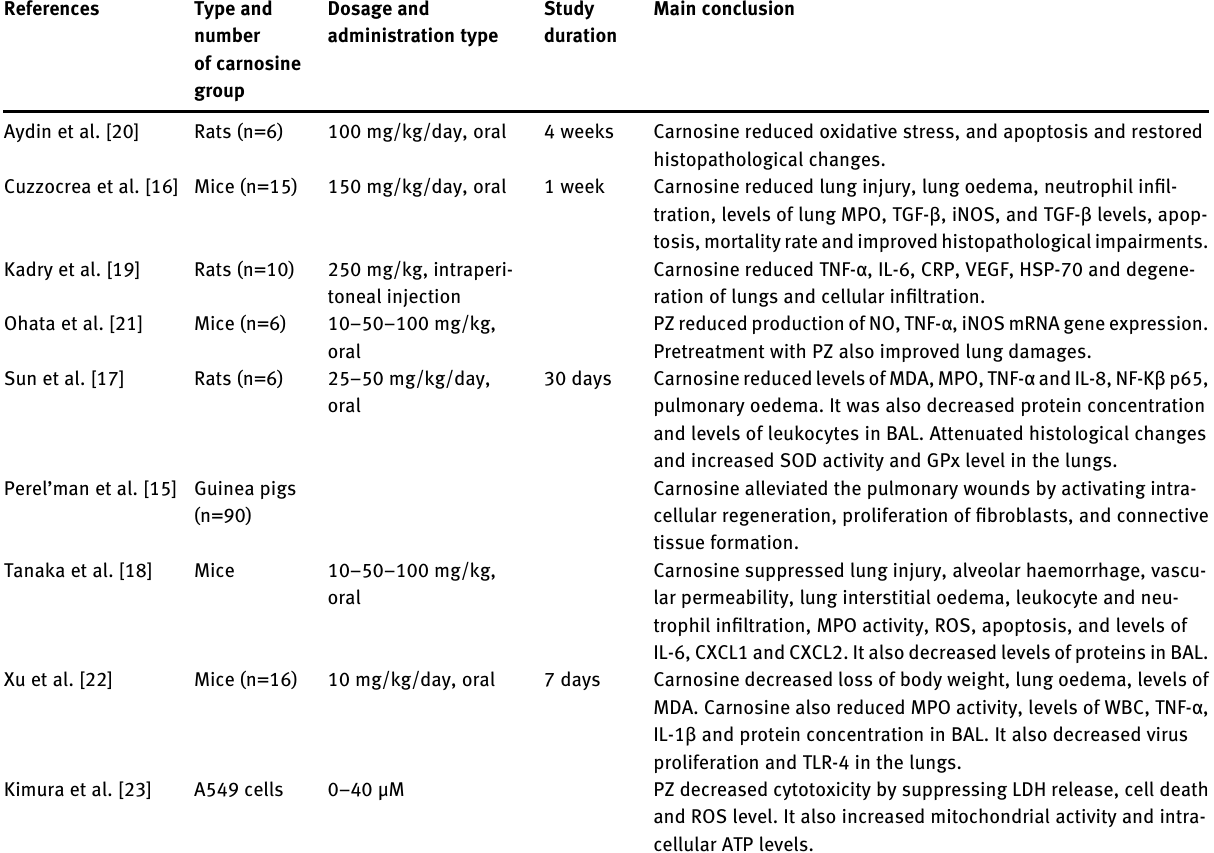
Table  : Characteristics of included studies in this systematic